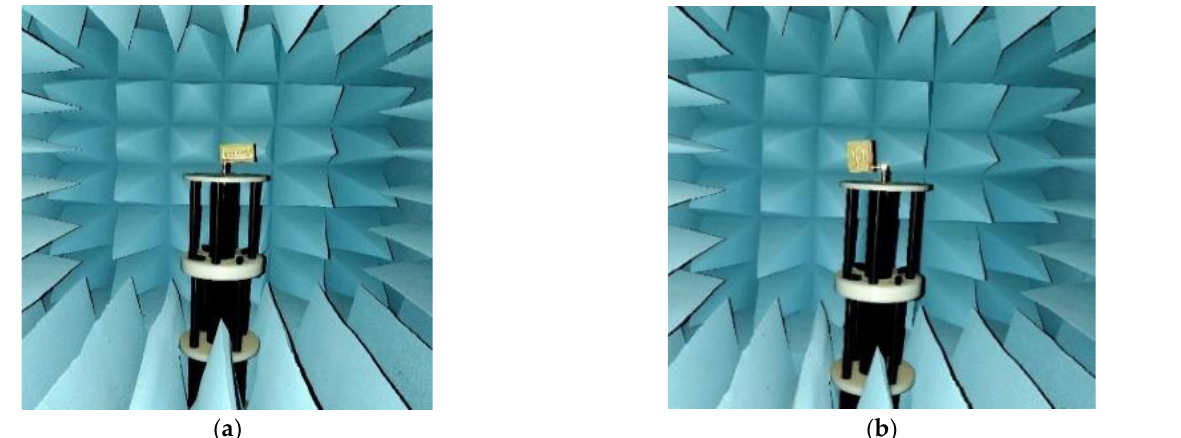
Figure 9. Testing set-up of the fabricated antenna in an anechoic chamber. ( a ) E-field ( b ) H-field. The two dimensions normalized radiation characteristics of the presented monopole antenna for azimuth (E-field) and elevation (H-field) plane are obtained and illustrated by Figure 10. It exhibits gain values of 3.7 dBi and 5.26 dBi, respectively. The simulated radiation pattern and measured radiation patterns are in close correlation.